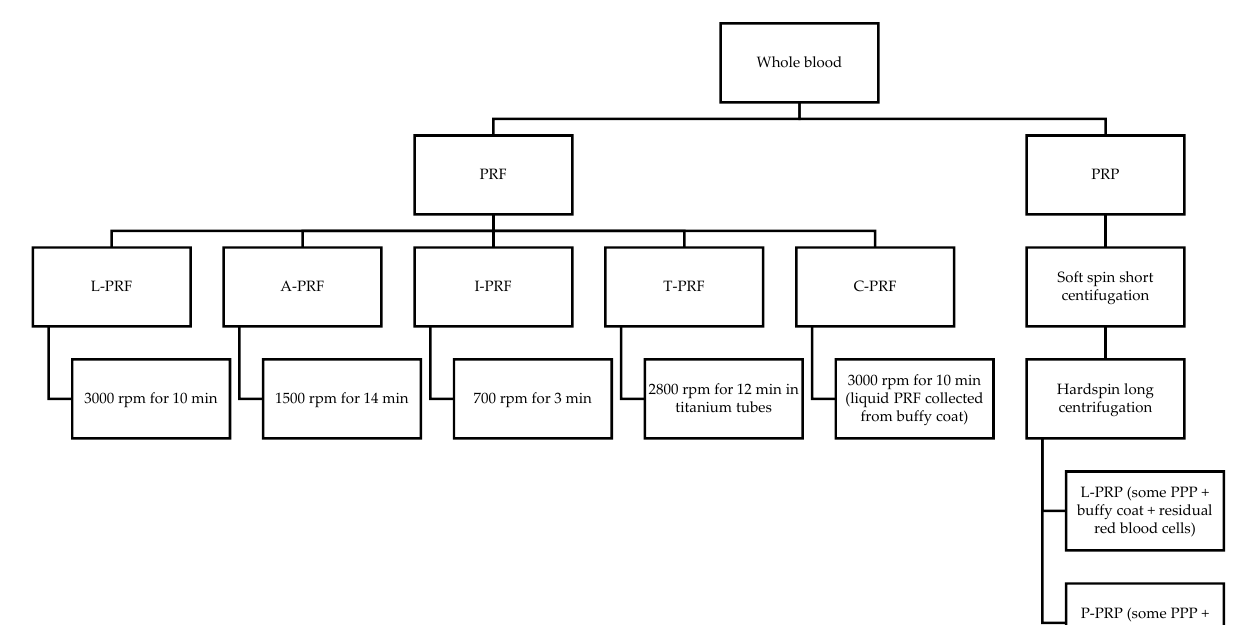
Figure 1. Preparation protocols of APCs. Abbreviations: PRF: Platelet-rich fibrin; L-PRF: leucocyte- and platelet-rich fibrin; A-PRF: advanced platelet-rich fibrin; I-PRF: injectable platelet-rich fibrin; T- PRF: titanium-prepared platelet-rich fibrin; C-PRF: concentrated platelet-rich fibrin; PRP: platelet-rich plasma; L-PRP: leucocyte-platelet-rich plasma; PPP: platelet-poor plasma; P-PRP: pure platelet rich plasma; rpm: rounds per minute, min: minutes.